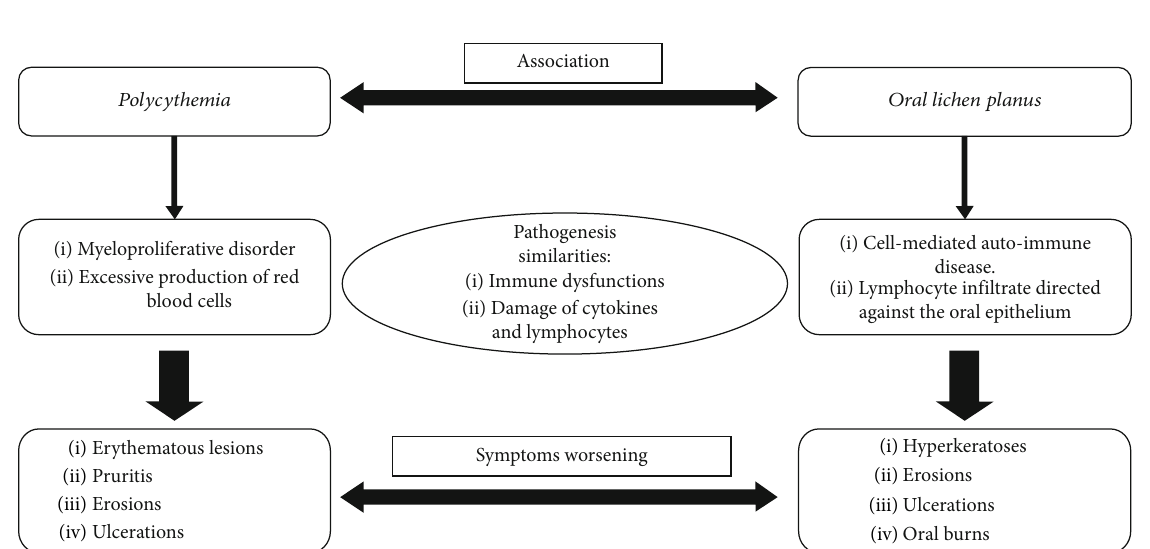
and the minor criterion